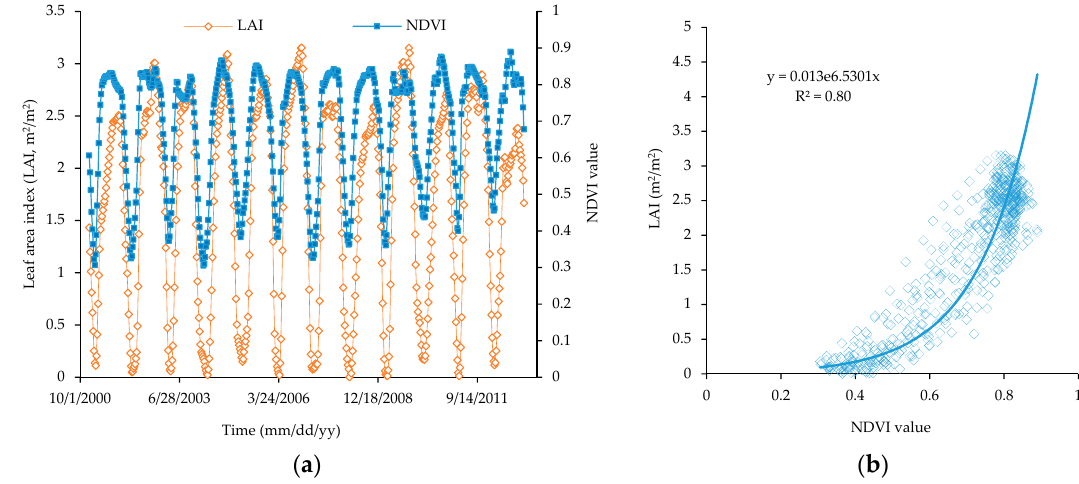
Figure 7. ( a ) Time series of in situ LAI against NDVI based on satellite data period 2001–2012; ( b ) the scatter plot of in situ LAI and NDVI based on satellite. The solid line shows the exponential relationship ( R 2 = 0.80).